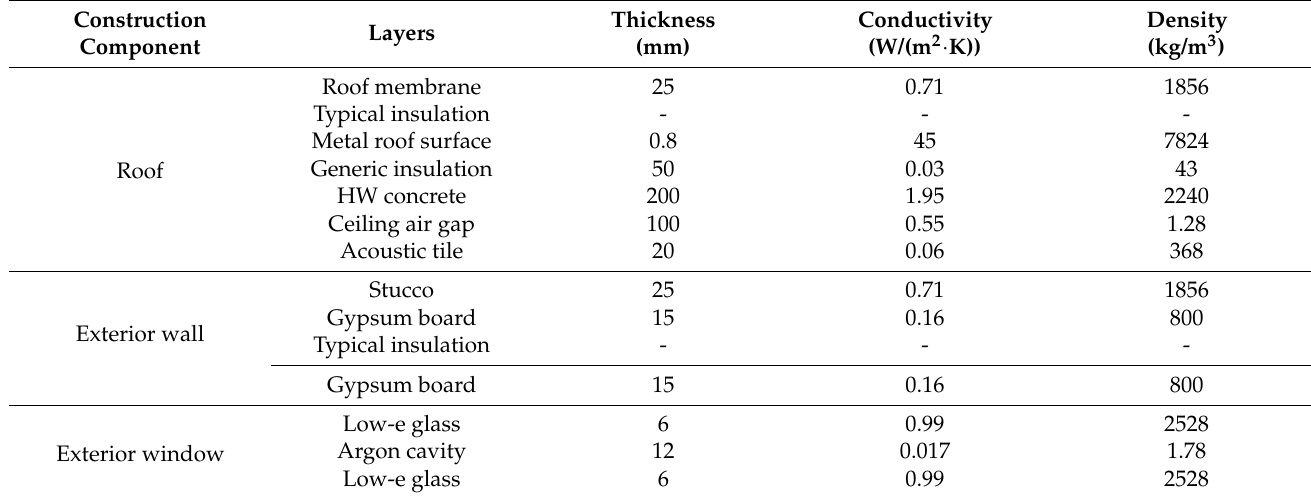
Table 3. Structural and material properties of the building envelope.